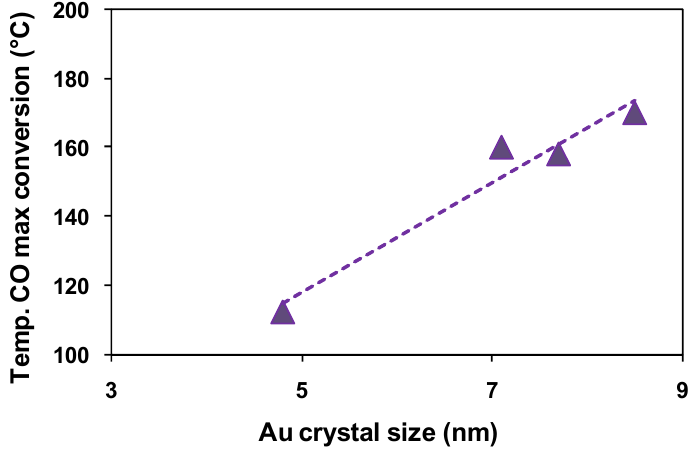
Figure 12. Temperature of the maximum CO conversion versus Au crystal size. Catalysts: Fe Au -Ce materials treated under different conditions and 2.3 2